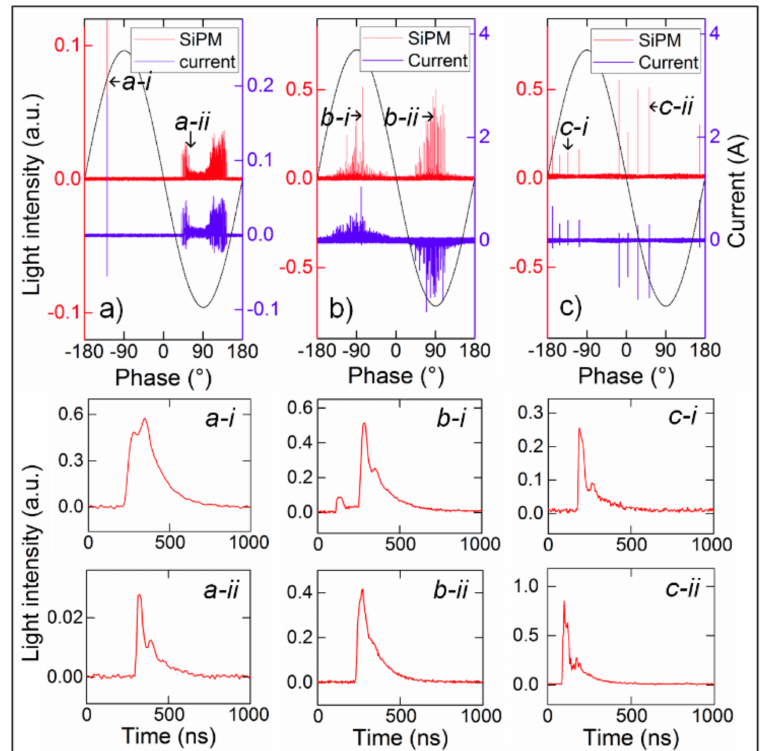
Figure 6. SiPM-detected light pulses with different types of PDs in air: ( a ) point discharges; ( b ) surface discharges; and, ( c ) floating